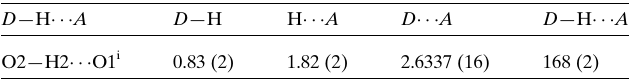
Table 2 Hydrogen-bond geometry (A˚ , (cid:2) ) for